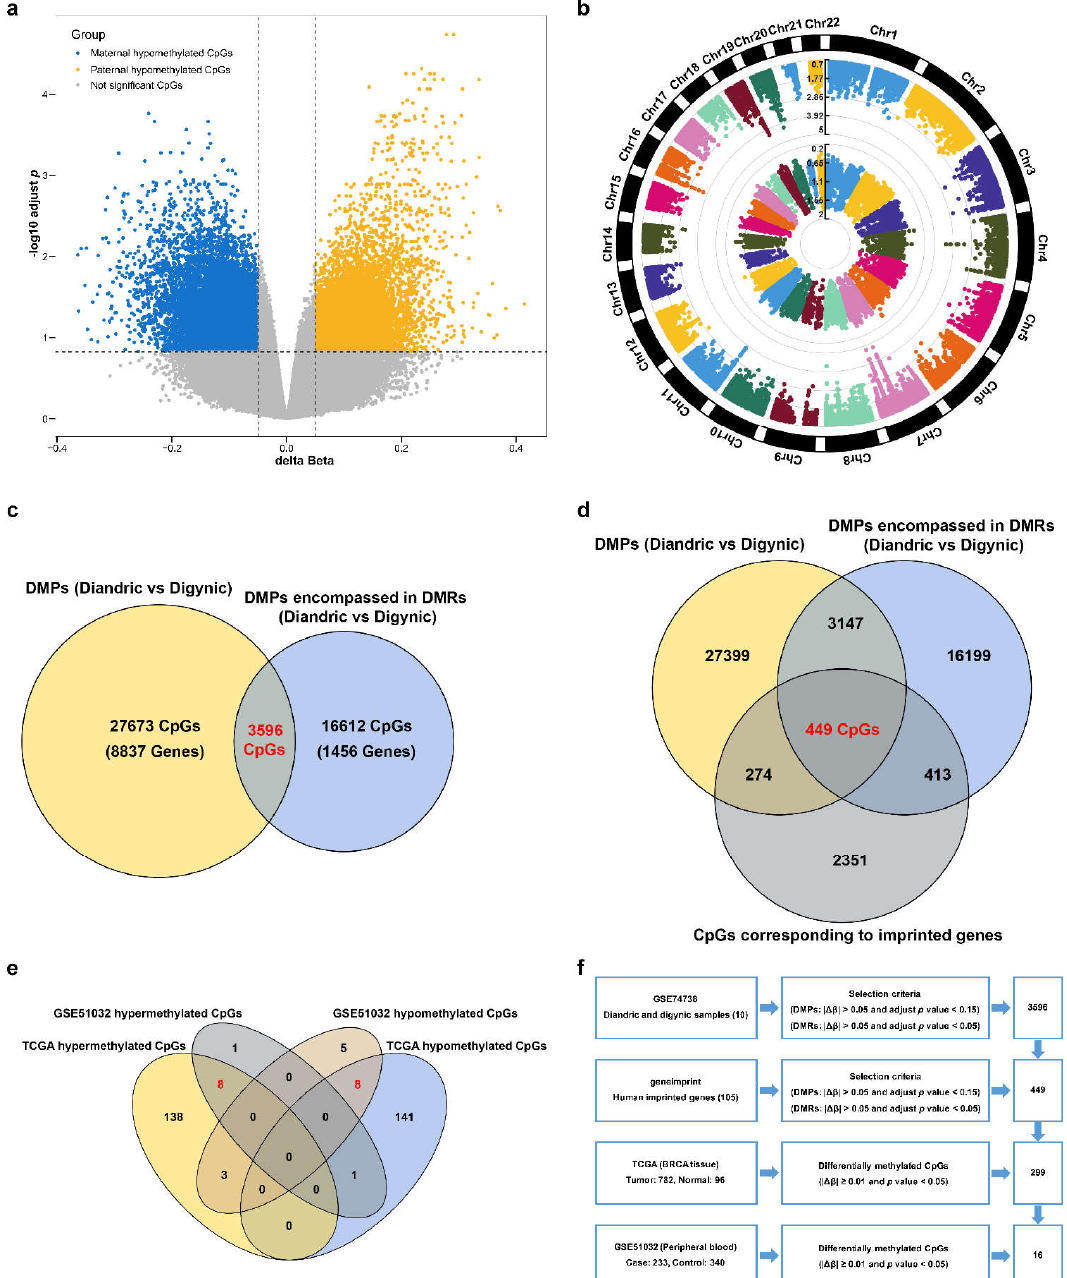
Figure 2. Discovery of the CpG sites of imprinted genes associated with the risk of breast cancer. DMP: differentially methylated position; DMR: differentially methylated region. ( a ) Differential methylation analysis comparing diandric and digynic triploids in the GSE74738 dataset. A volcano plot shows the -log10-adjusted p -value against the log2 delta beta for each CpG site. ( b ) Manhattan plot showing the chromosome (chr) and positional (pos) information for DMPs in the GSE74738 dataset. Dots in the inner ring represent -log10 |Δβ|, and dots in the outer ring represent -log10 FDR. ( c ) A two-way Venn diagram showing the intersection of DMPs from differential methylation analysis comparing diandric and digynic triploids and CpG sites encompassed in DMRs. ( d ) A three-way Venn diagram showing the intersection of DMPs, CpG sites encompassed in DMRs, and CpG sites corresponding to imprinted genes. ( e ) A four-way Venn diagram showing the intersection of differentially methylated CpG sites in the TCGA and GEO datasets (GSE51032). ( f ) A workflow for identification of the CpG sites of imprinted genes associated with the risk of breast